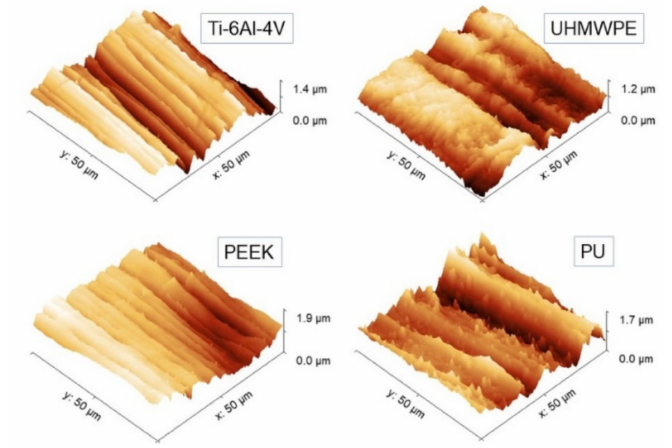
Figure 3. Representative 50 × 50 µ m 2 AFM topographies of the four surfaces investigated. All the images have been displayed at the same rotation angle for a guide to the eye.